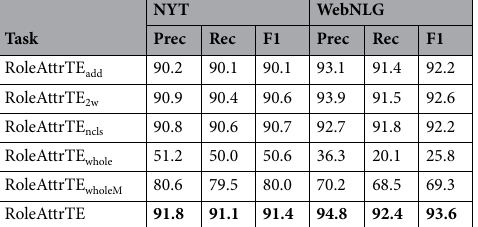
Table 5. Evaluation of comparison methods for feature fusion and prediction of triple extraction submodule.